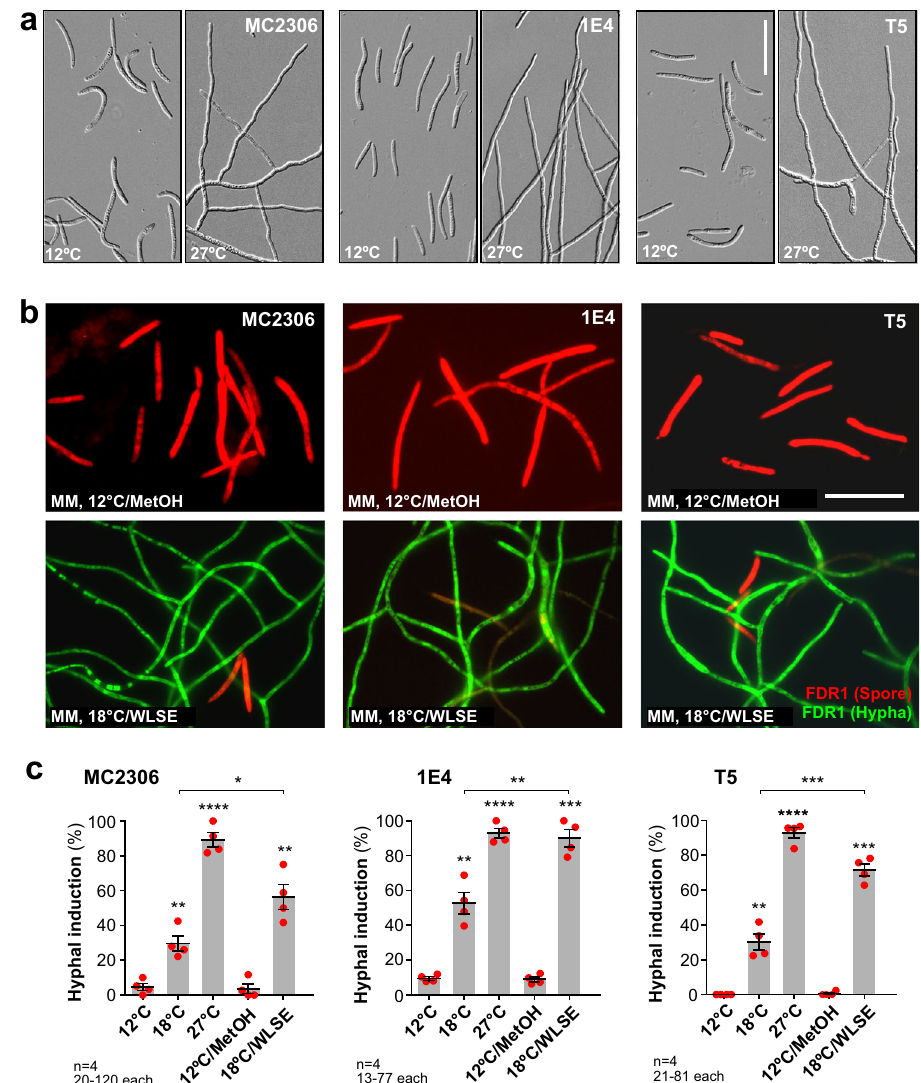
Fig. 3 | Response of alternative wildtype strains to environmental cues. a Morphology of strains MC2306, 1E4 and T5 in MM at 12 and 27°C. All strains respond to higher temperatures by forming hyphae. Scale bar=30 µ